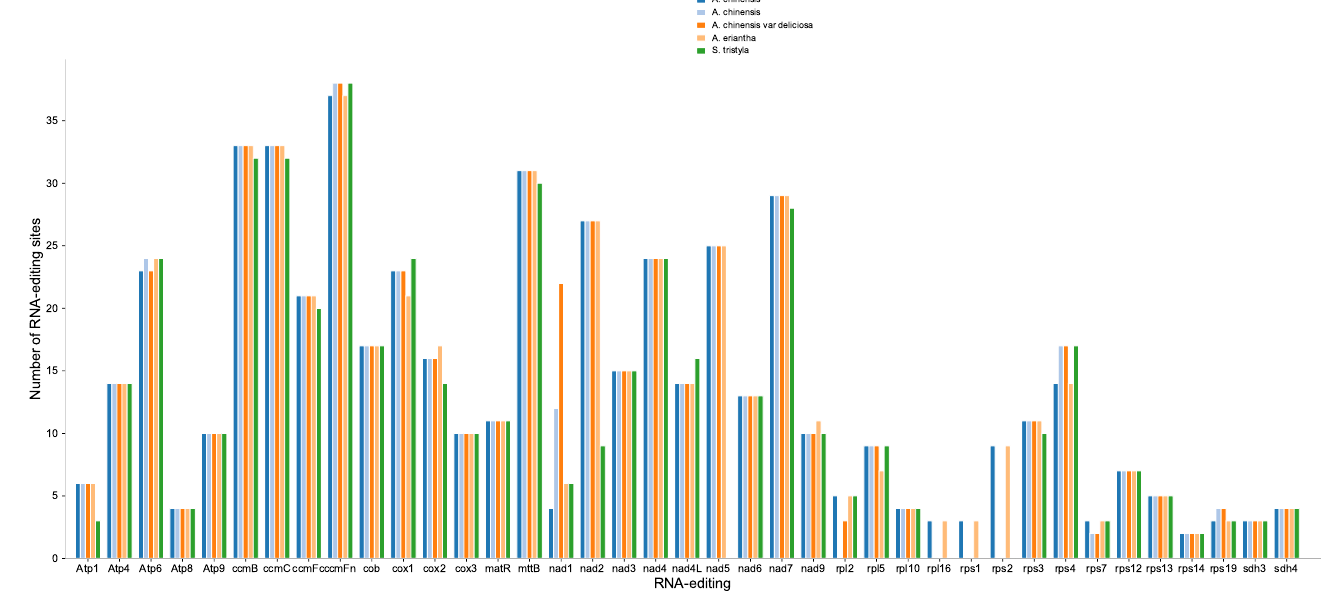
Figure 4. The distribution of RNA editing sites in mitogenome protein-coding